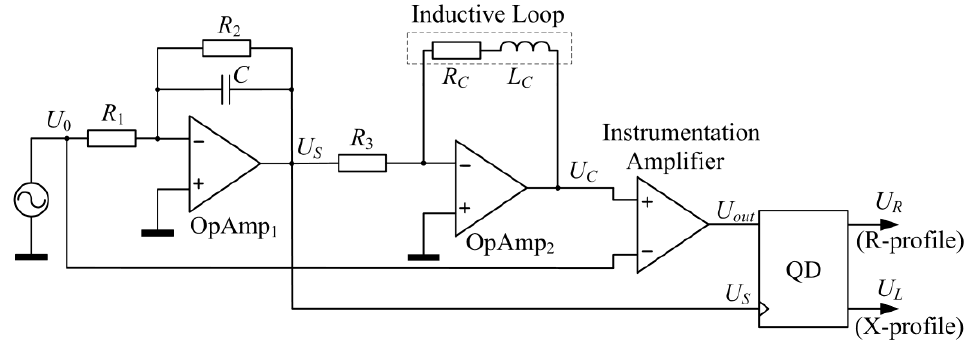
Figure 1. Sensor amplifier, where QD—Quadrature Demodulator (details shown in Figure 2). The input